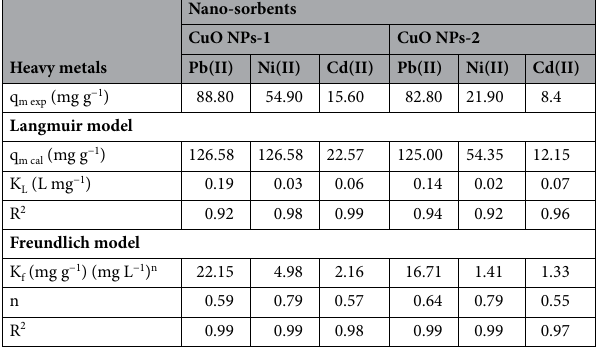
Table 1. Isotherm parameters and correlation coefficients for the investigated heavy metals using nano- sorbents (CuO NPs-1 and CuO NPs-2).